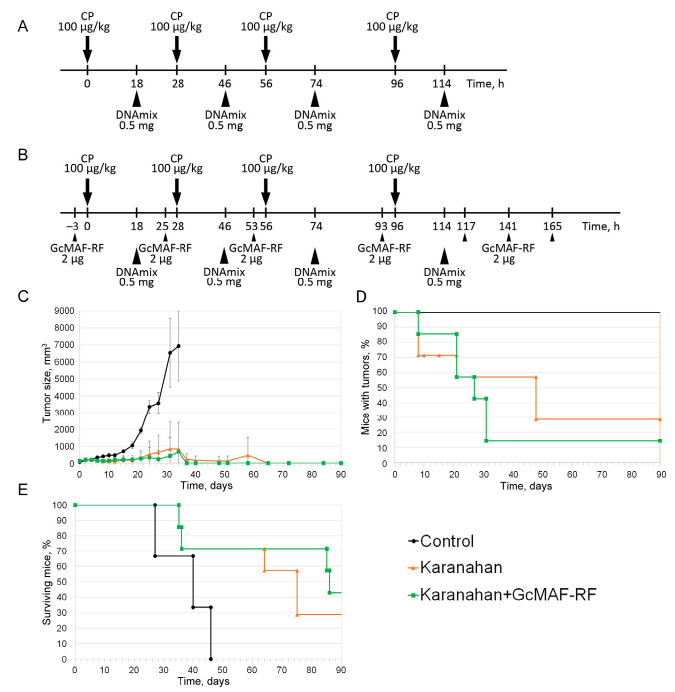
Figure 6. Comparison of the antitumor efficacy of the Karanahan approach alone and in combination with intratumoral injections of GcMAF-RF in the model of weakly immunogenic Lewis carcinoma. ( A ) Therapeutic regimen for treating Lewis carcinoma using the Karanahan approach. ( B ) Therapeutic regimen for treating Lewis carcinoma using the Karanahan approach in combination with intratumoral injections of GcMAF-RF. Arrows indicate intraperitoneal injections, arrow- heads—intratumoral. ( C ) Changes in tumor growth in the study and control groups. Mean ± SD values are shown. ( D ) Changes in the number (%) of mice with tumors. ( E ) Animal survival graph. Abundant purulent discharge from the treated paw (presumably neutrophilic in- flammation caused by neutrophil attraction to the tumor growth site) was noted on day 15 to 27 in some mice. Tumors disappeared completely after the formation of purulent